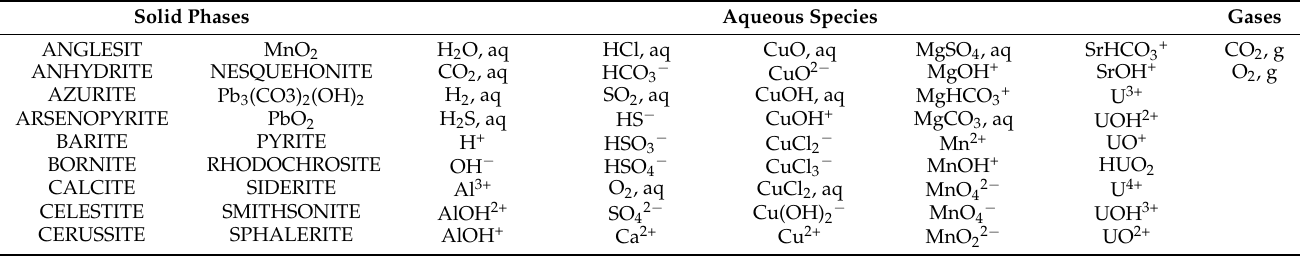
Table 1. Solid phases, aqueous species, and gases taken into account in